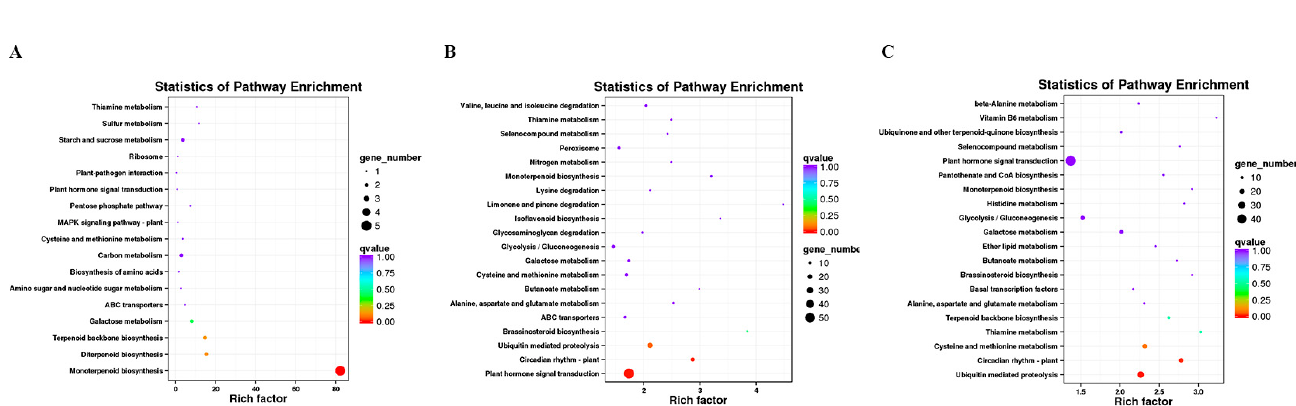
Figure 2. Scatter plot of KEGG pathway enrichment of up-regulated DEGs. ( A ) B vs. Q; ( B ) Q vs. R; ( C ) B vs. R.